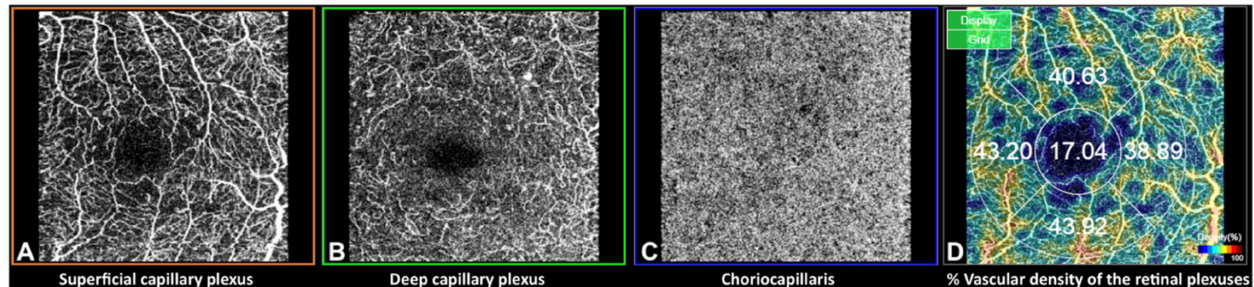
Figure 1. Optical coherence tomography angiography (OCTA) in a 3 × 3 mm macular area of the left eye, measured by deep range imaging (DRI) Triton swept-source (SS)-OCT. ( A ) Superficial capillary plexus, ( B ) deep capillary plexus, ( C ) choriocapillaris and ( D ) an example of vascular density (%) data of the retinal plexuses in 5 areas (abbreviated C: Central, S: Superior, T: Temporal, N: Nasal and I: